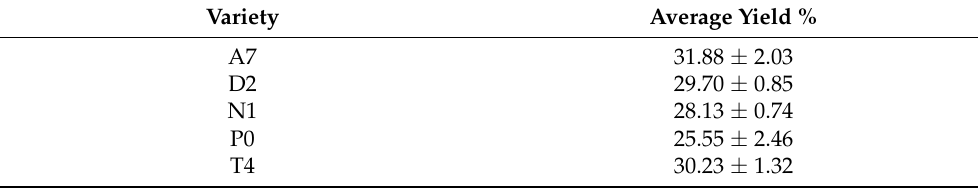
Table 2. Cannabis sativa varieties extraction yield expressed as % plant dry weight (average ± SE).